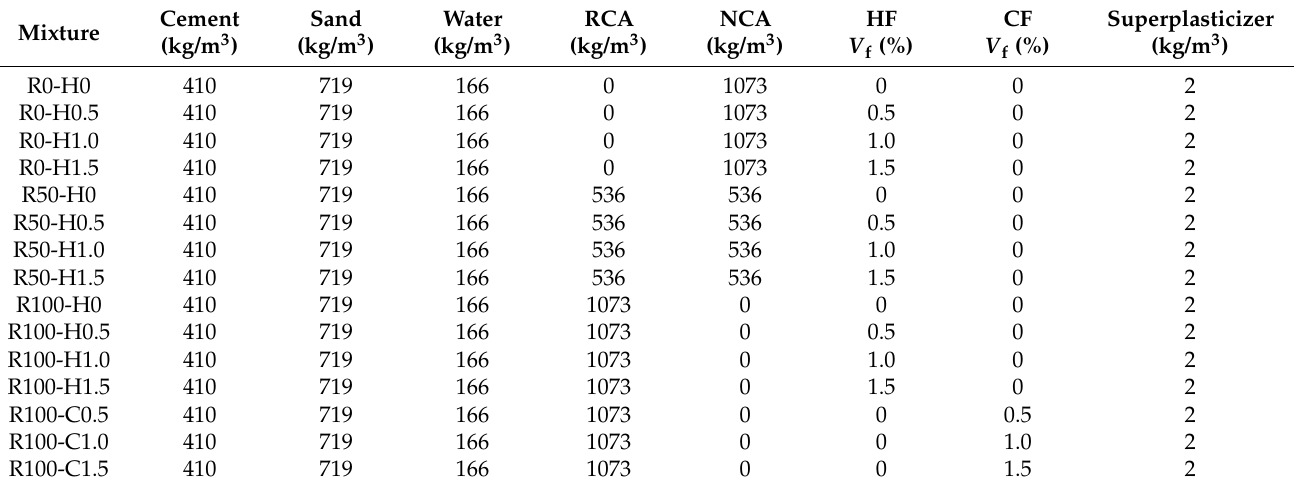
Table 4, “R”, “H”, and “C” represent RCA, HF, and CF, respectively. The numbers “0”, “50”, and “100” represent the replacement percentage of NCA by weight, and the numbers “0”, “0.5”, “1.0”, and “1.5” represent the volume fraction of steel fiber incorporated in natural aggregate concrete (NAC) and RAC. For example, R50-H0.5 denotes SFRAC with a 50% RCA replacement ratio and 0.5% HF content. Table 4. Mix proportions of the concrete